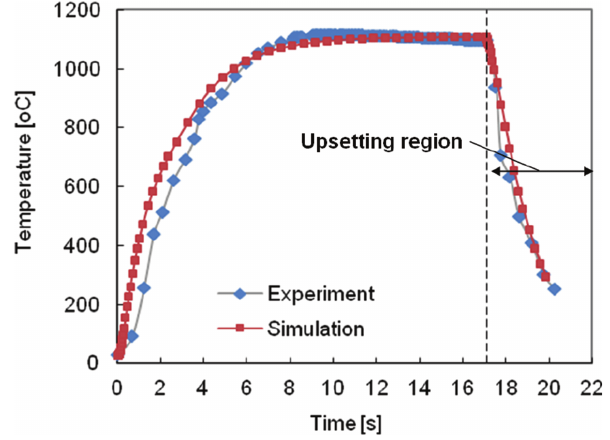
Figure 11: Time dependence of the temperature in the center of the billet in the experiment and the